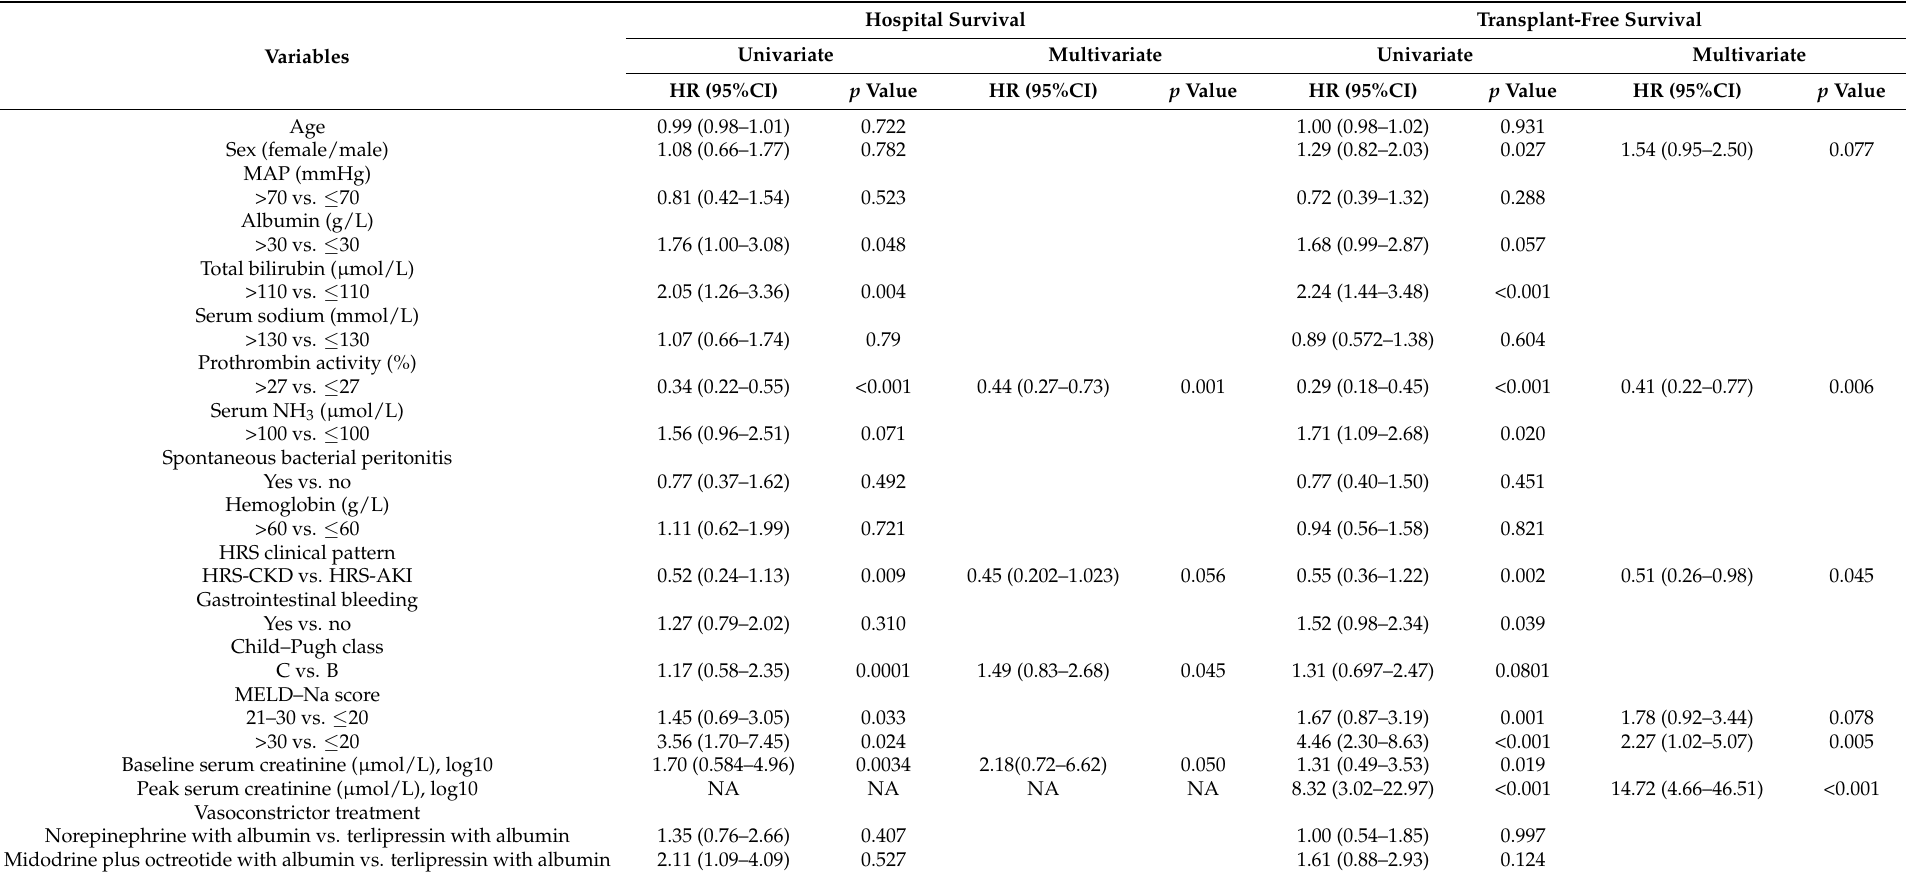
Table 2. Cox proportional hazards regression analysis showing the association of variables with hospital survival and with transplant-free survival.